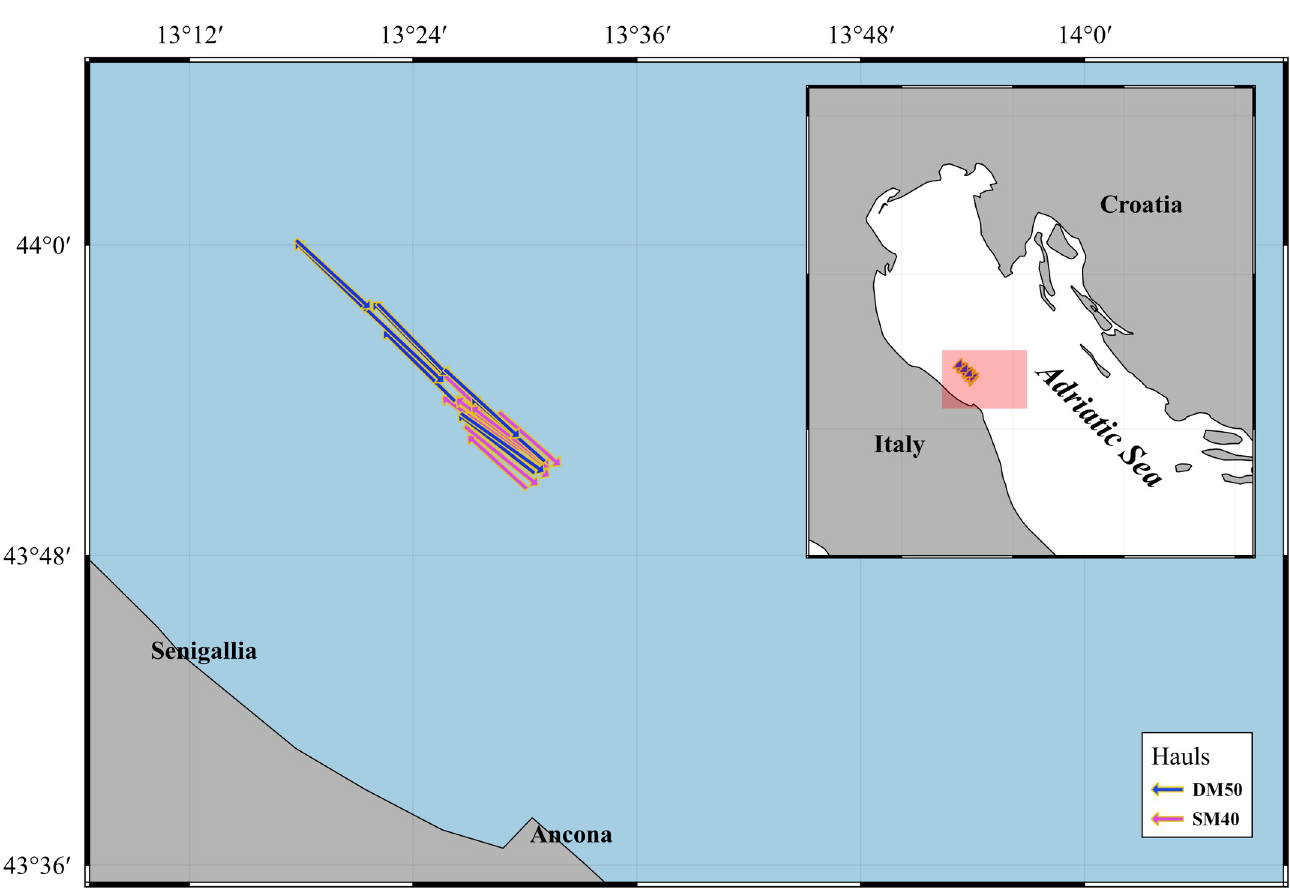
Fig 1. Map of the hauls carried out during the sea trials, distinguished by codend type (SM40: 40 mm square mesh codend; DM50: 50 mm diamond mesh codend). The arrows indicate the towing direction.